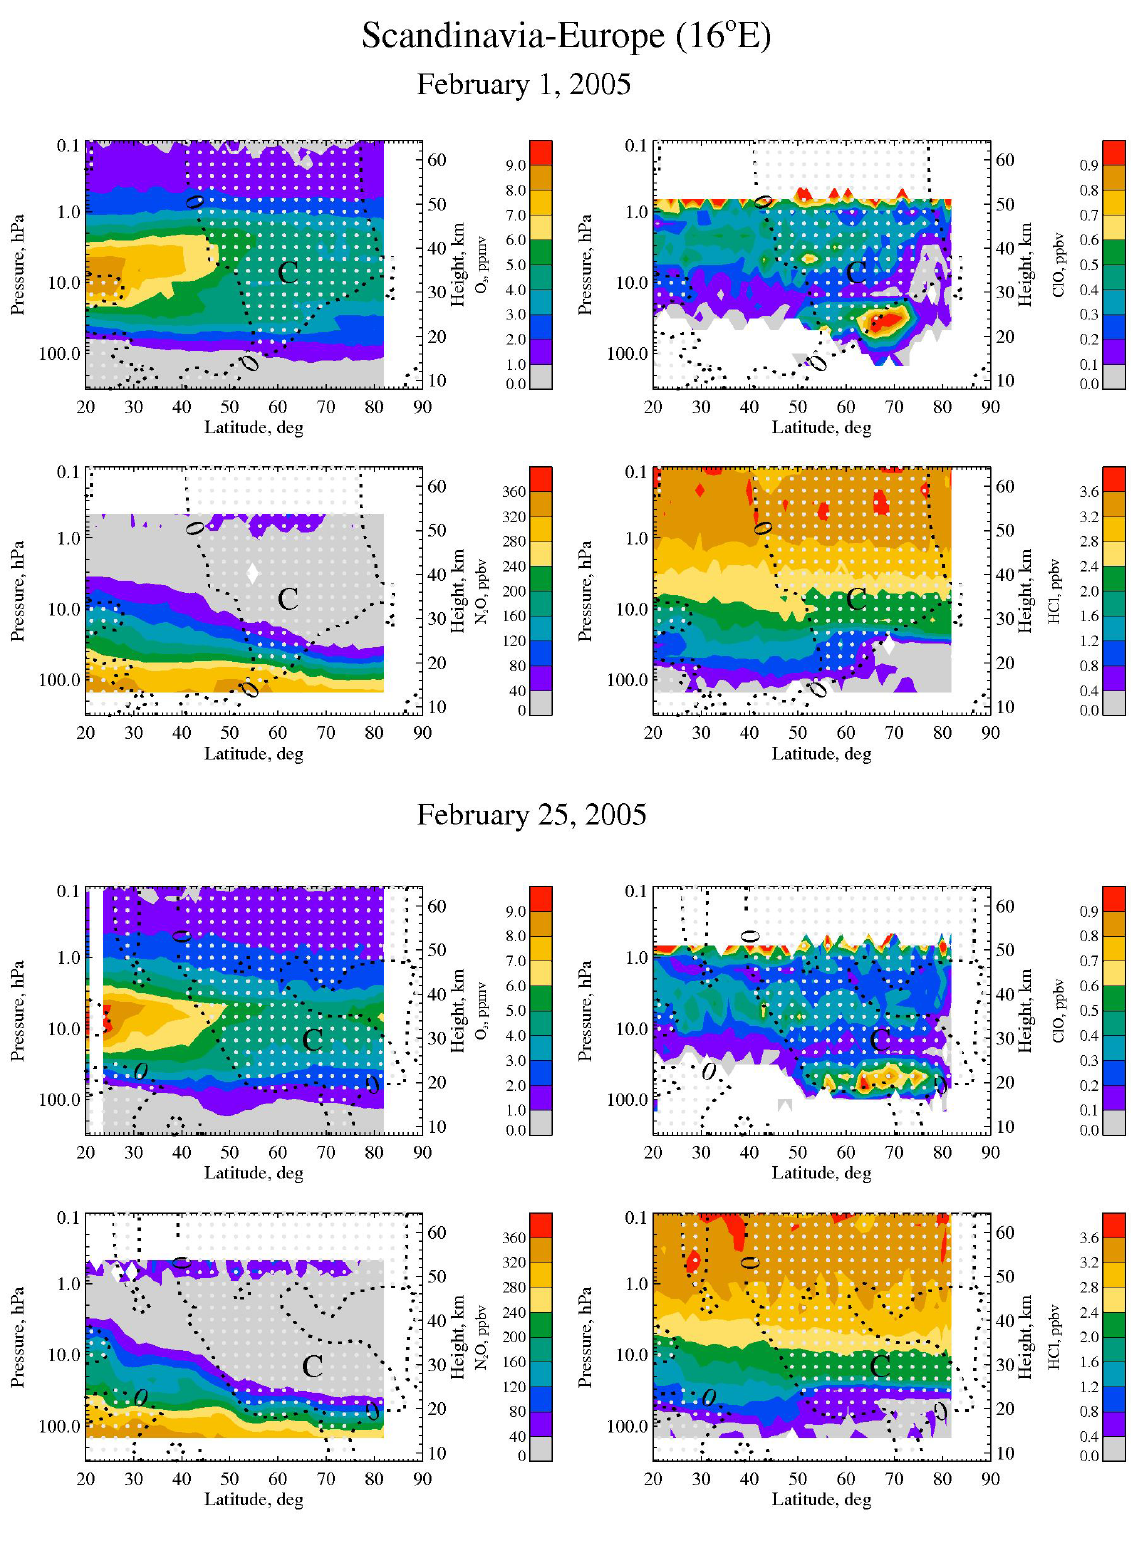
Fig. 5. Contour plots for mixing ratios of four chemicals (Aura MLS) are shown for 1 and 25 February, at the chosen longitudinal sector through Svalbard-Tromso-Collm (16 ± 12.5 ◦ E). Otherwise details are as in Fig.